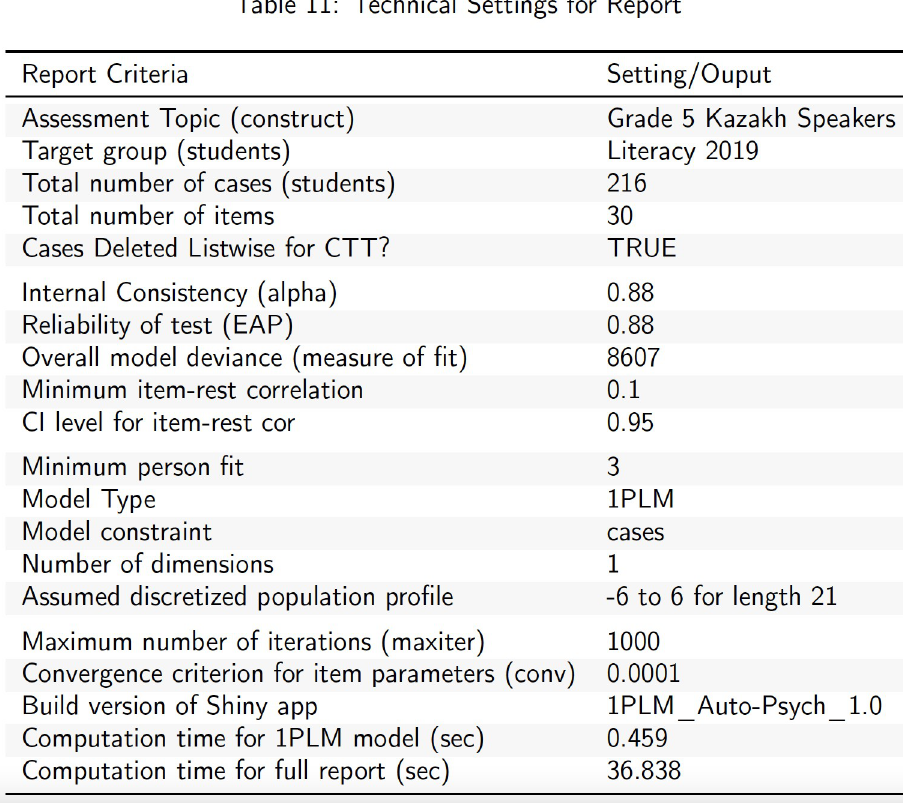
Fig 6. Summary of technical settings and